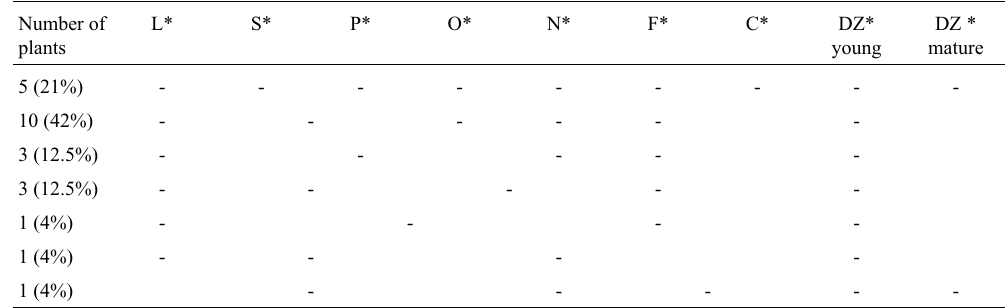
Table 1 - GUS expression of SHP2 enhancer- GUS plants (pARC751). Number of plants